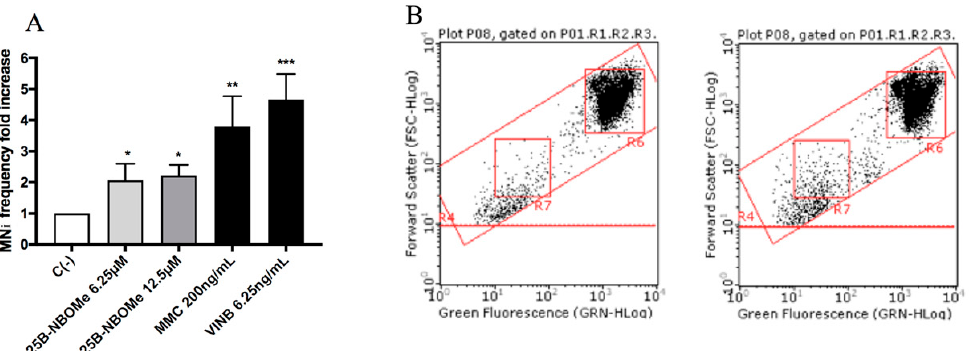
Figure 7. The MNi frequency fold increase on TK6 cells after 26 h treatment with 25B-NBOMe at the indicated concentrations with respect to the untreated negative control [C (-)] and to positive controls [MMC and VINB]. ( A ) The plot of the nuclei and MNi in the untreated control ( B ), and in 12.5 µM 25B-NBOMe -treated cultures (C). Each bar represents the mean ± SEM of five independent experiments. Data were analysed using repeated ANOVA followed by Bonferroni post-test. * p < 0.05 vs C (-), ** p < 0.01 vs C (-); *** p < 0.001 vs C (-).